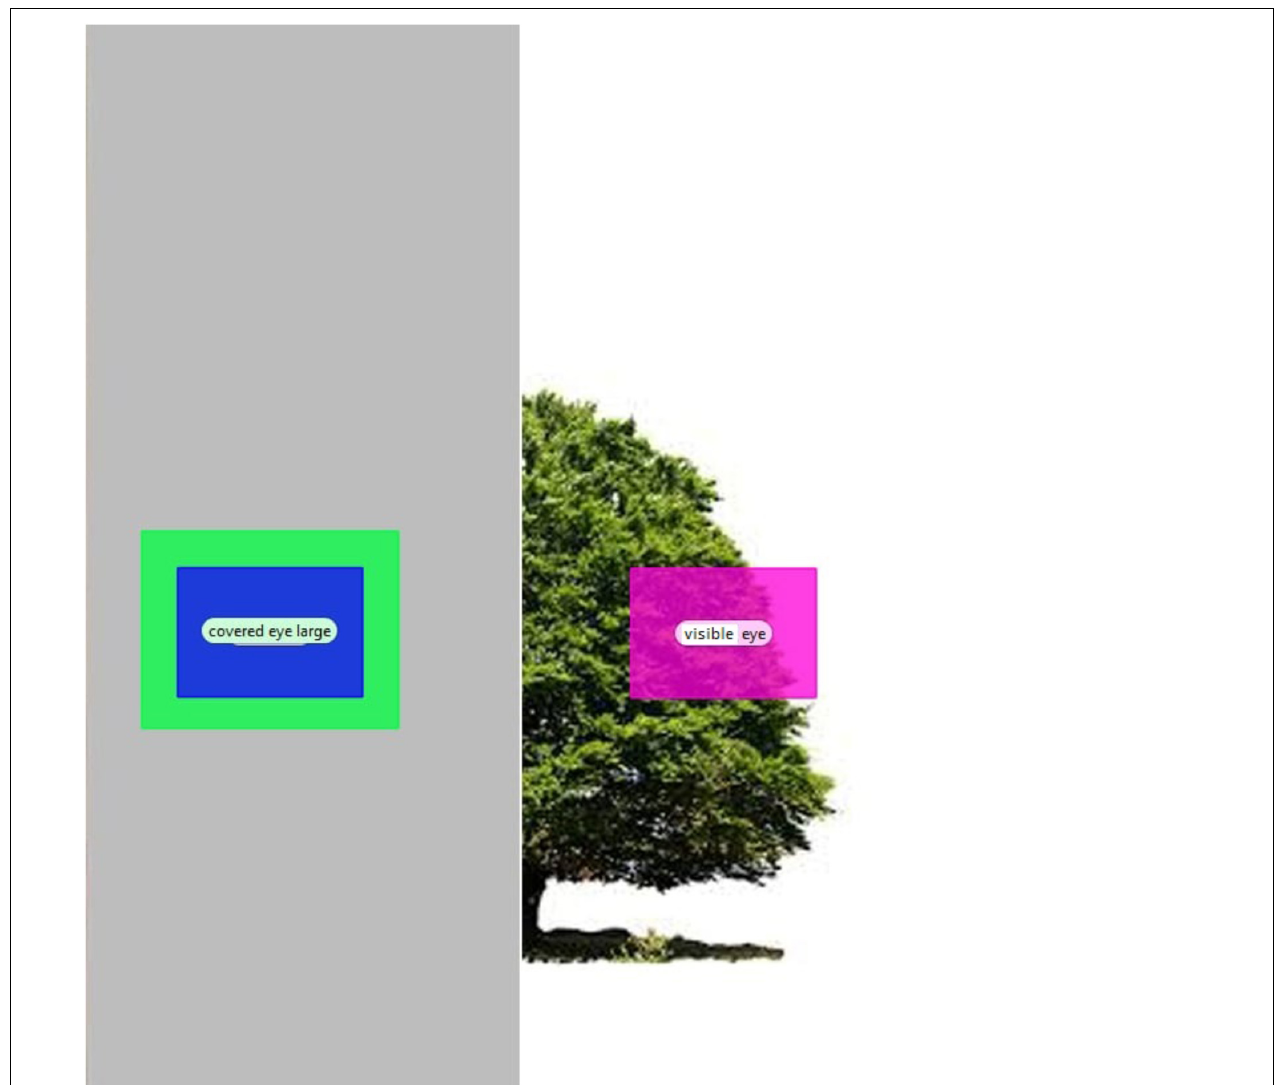
FIGURE 10 | Areas of interest for a tree